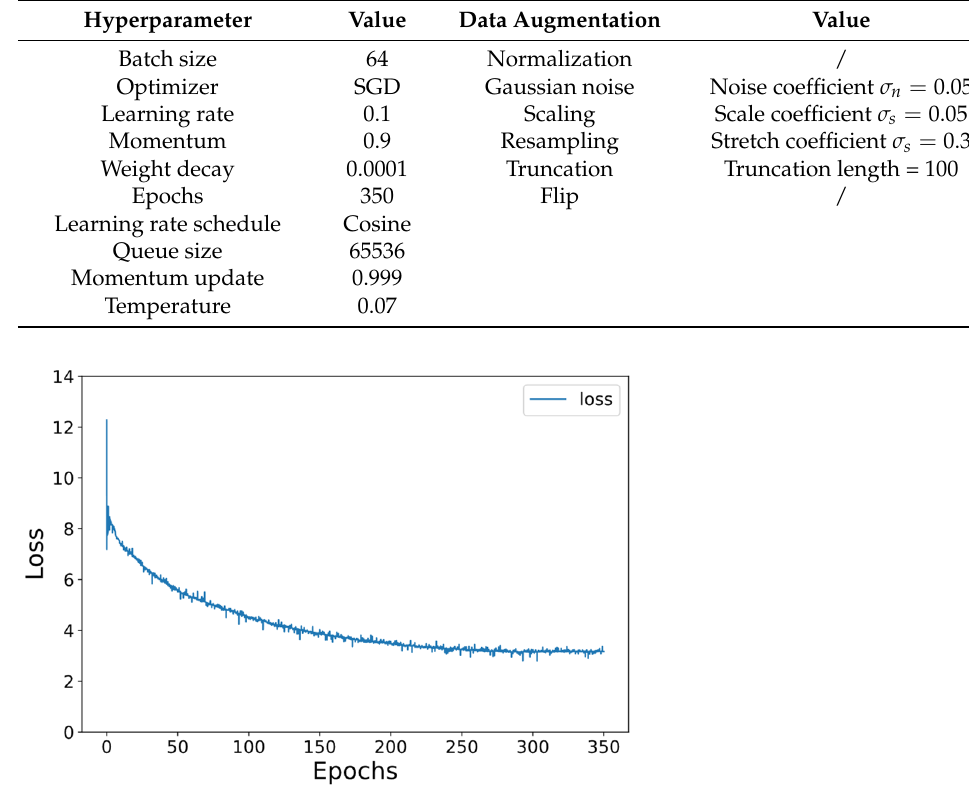
Table 3. Hyperparameter setting.